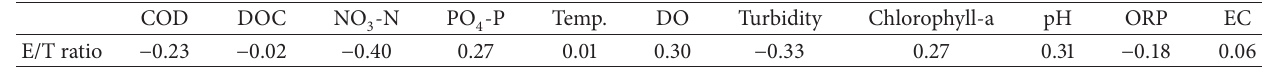
Table 3: Correlation coefficients for each parameter with E/T